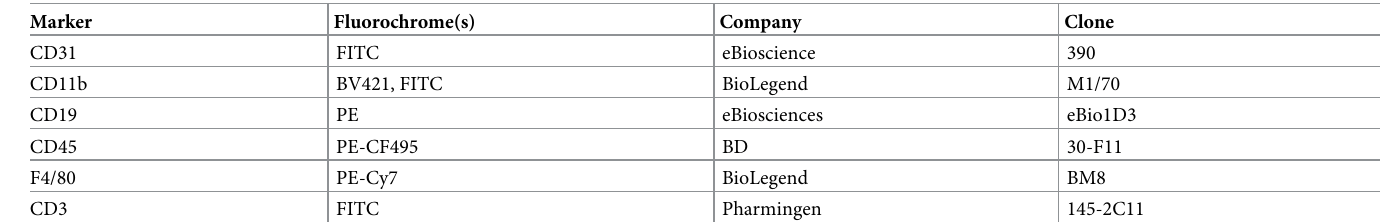
Table 2. Antibody list. Marker